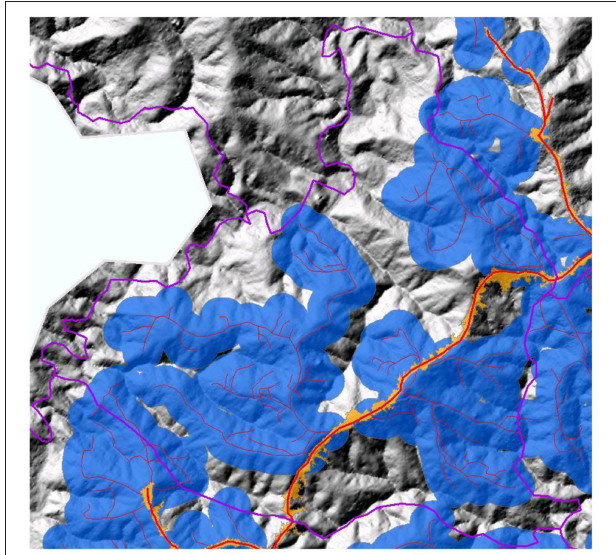
FIGURE 1 | Lidar-delimited (1:10,000) skidding/felling (blue) and haul-road (orange) impact zones in an FME in Kalimantan, Indonesia with purple lines demarcating the logging block boundaries, ridges are indicated by dark shading, valleys with light shading, and the logging road in red (reprinted with permission from Ellis et al., 2016). Note that timber in the area to the northwest was not yet